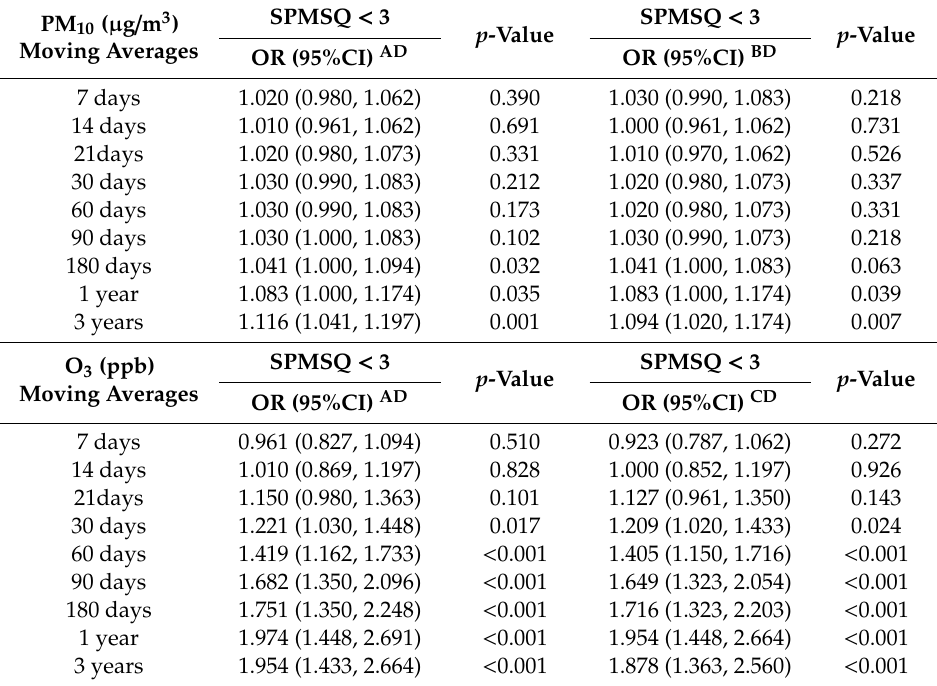
Table 2. ORs (95% CIs) for moderate-to-severe cognitive impairment per 10 µ g / m 3 PM 10 and per 10 ppb O 3 (n =